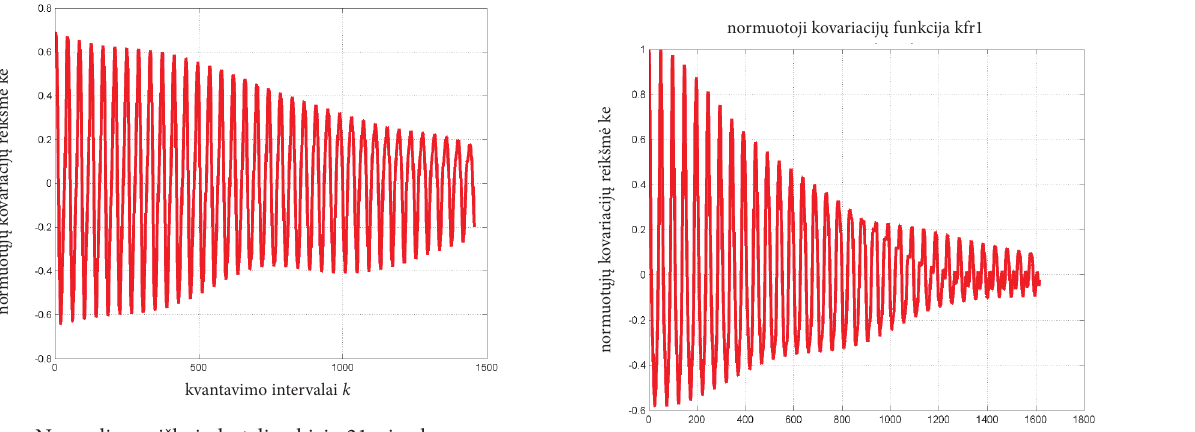
4 pav . Normalių vyriškųjų ląstelių abiejų 21-ųjų chromosomų tarpusavio normuotoji kovariacijų funkcija Fig. 4 . Interrelation normalised covariance function of both normal male chromosomes 21 in cells